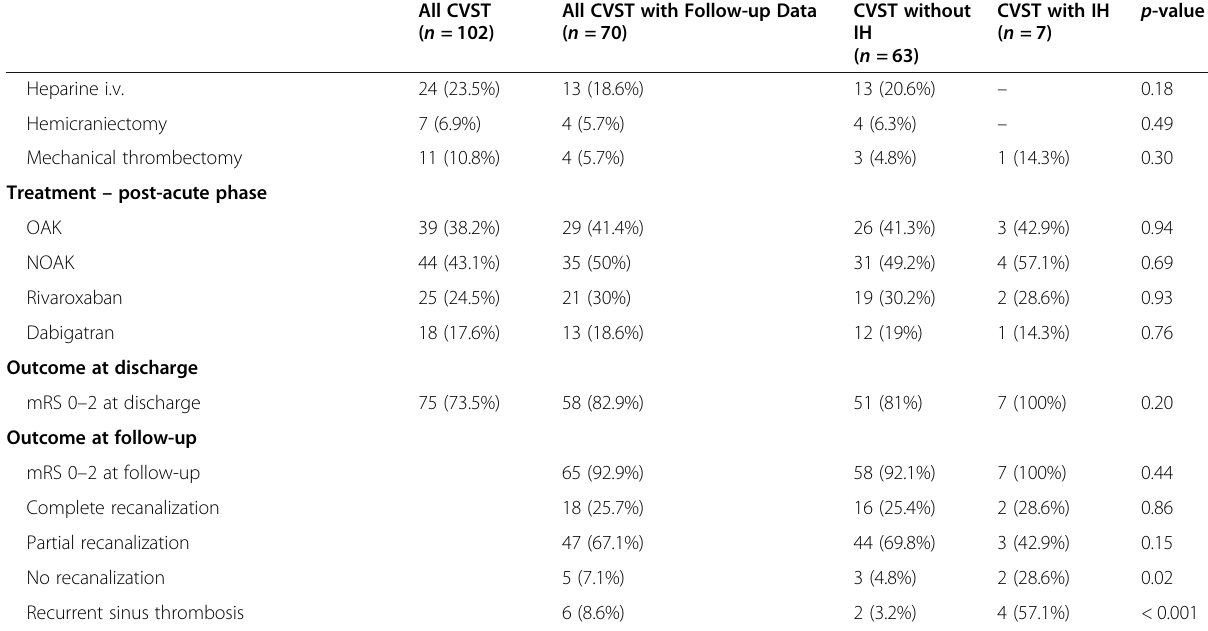
Table 2 Characteristics of all CVST-patients, all CVST-patients with Follow-up Data, CVST- patients without IH and with IH. Age is expressed as median (min-max) with *Mann-Whitney-U-Test, categorical data expressed as n (%) with Chi-Square-Test (Continued) All CVST All CVST with Follow-up Data ( n = 102) ( n =